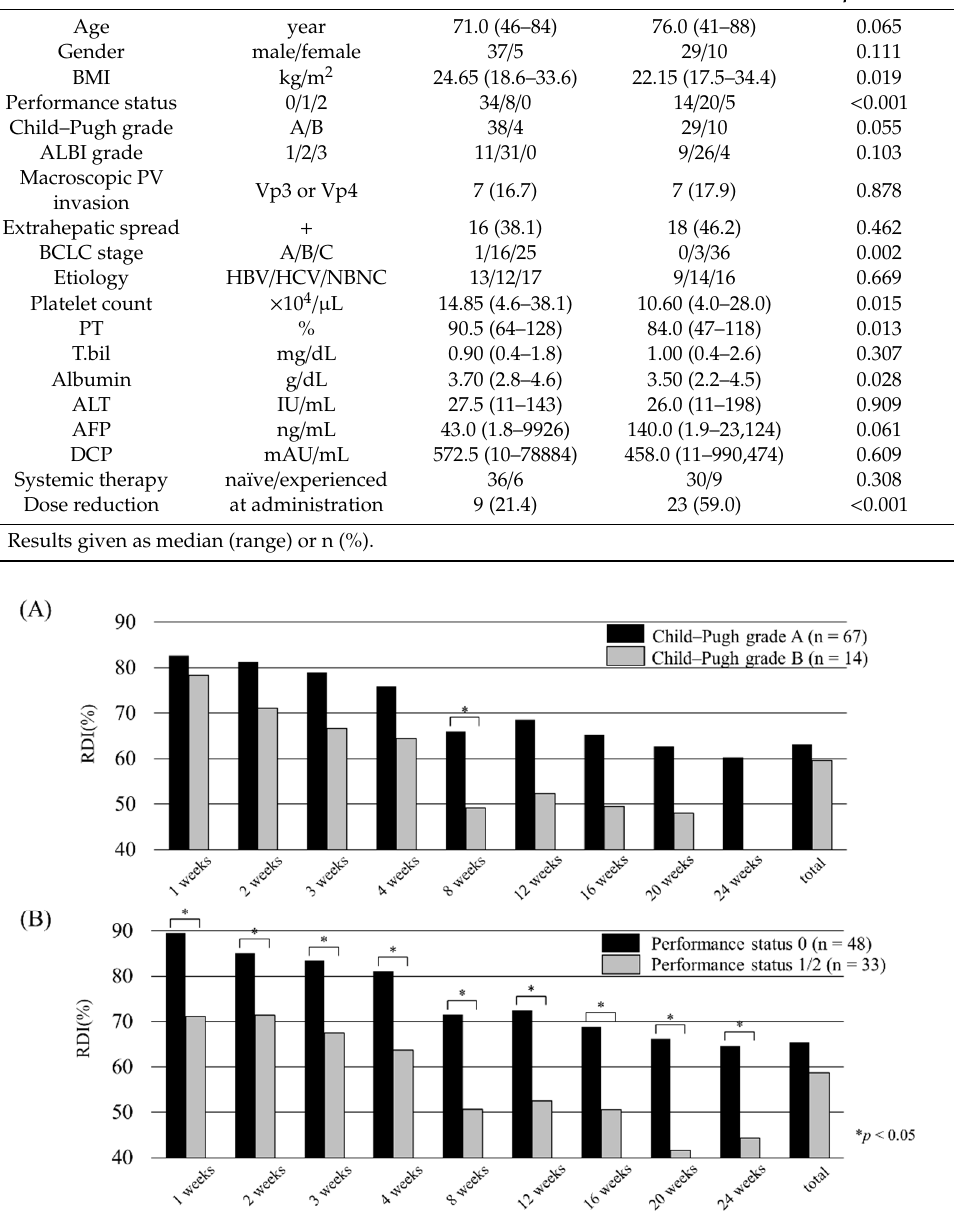
Figure 7. Relative dose intensity of lenvatinib stratified by ( A ) Child–Pugh grade and ( B ) radiological response. ( A ) RDI for each week stratified by Child–Pugh grade A (black bars) and Child–Pugh grade